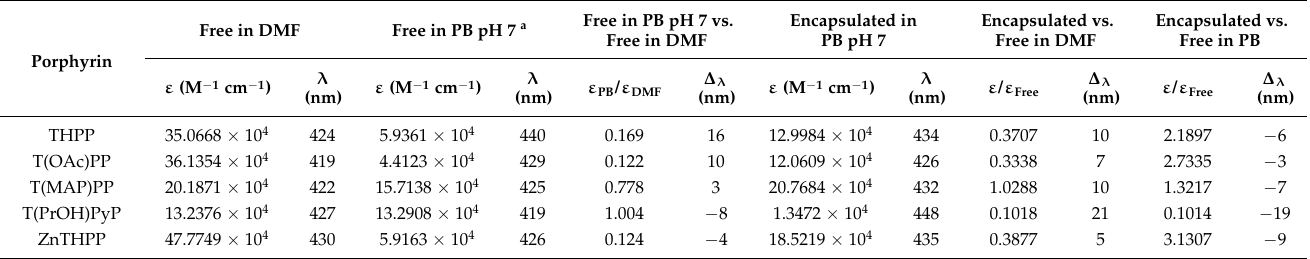
Table 2. Absorption spectra properties at the Soret band wavelength of different porphyrins dissolved in DMF or PB pH 7, or encapsulated in acetylated lignin nanoparticles, and suspended in PB pH 7. The effect of encapsulation on the absorption capacity of the porphyrins is described as the ratio of absorption coefficients of the encapsulated porphyrins and of the free porphyrins ( ε / ε Free ). Additionally, the shift of the observed Soret bands wavelength upon encapsulation is given ( ∆ λ ). Free in DMF Free in PB pH 7 a Free in PB pH 7 vs. Free in DMF Encapsulated in PB pH 7 Encapsulated vs. Free in DMF Encapsulated vs. Free in Porphyrin